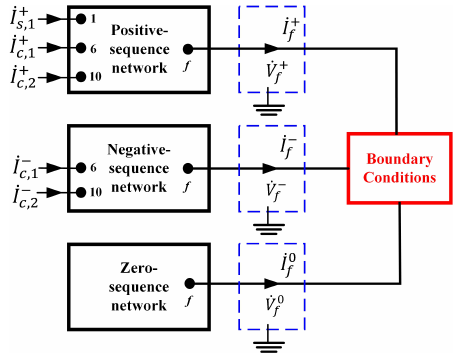
Figure 4. Sequence networks of the test system subject to a fault at bus f